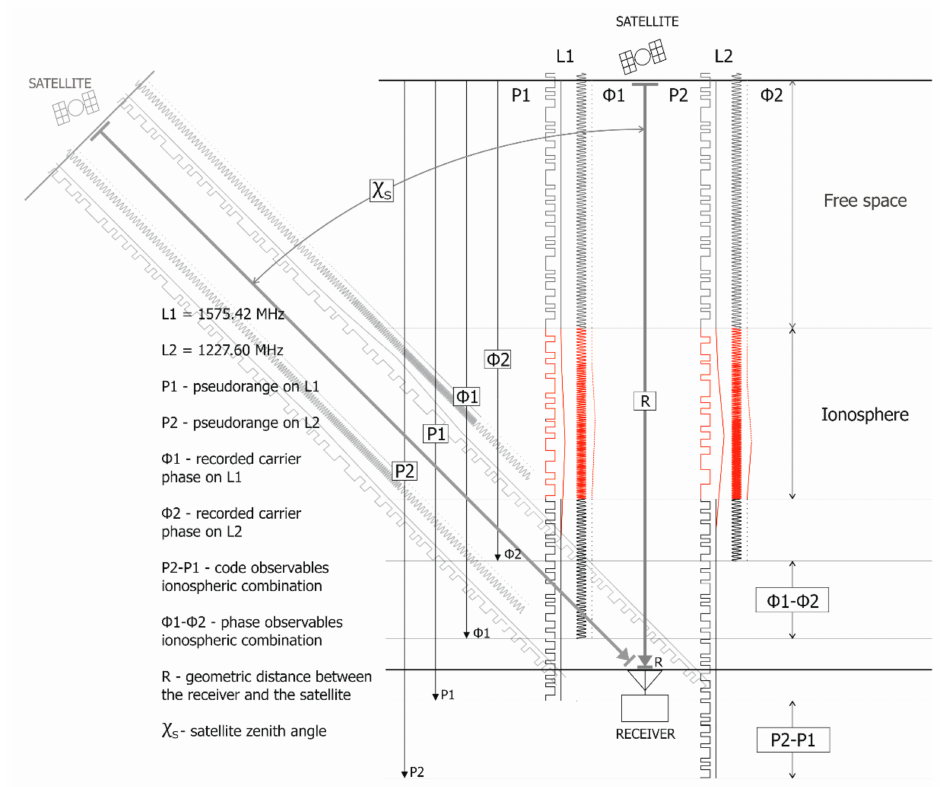
Figure 1. Total electron content (TEC) determination method based on ionospheric GPS dual- frequency combinations. Adapted and modified on the basis of [64,65].